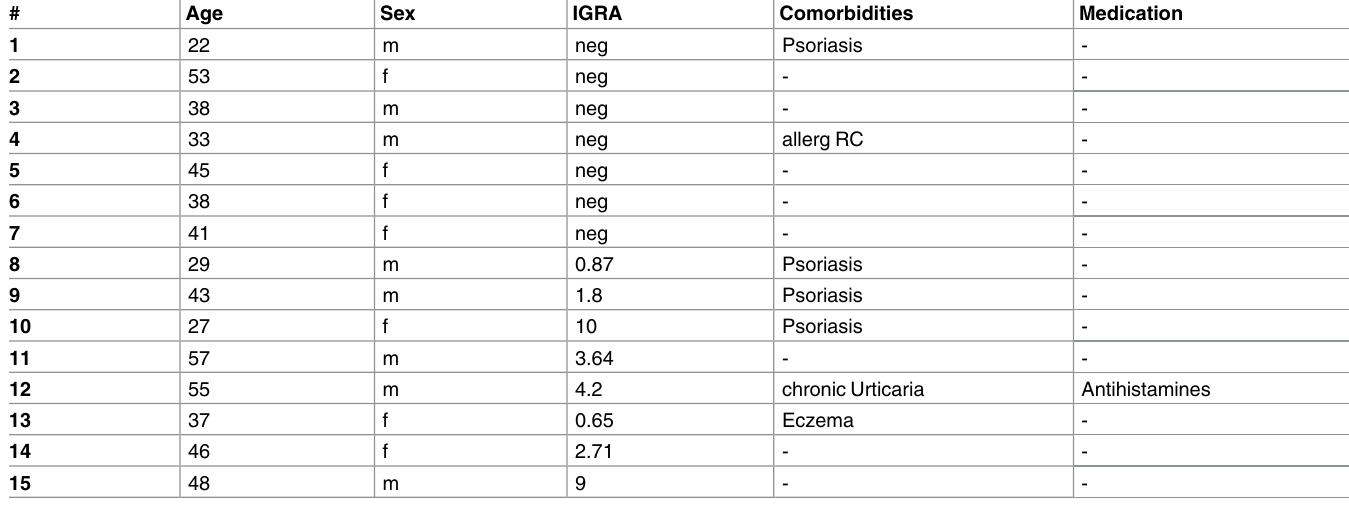
Tablenotes: #: patient number; Sex—m: male; Sex—f: female; neg: negative; allerg RC: allergic rhinoconjunctivitis